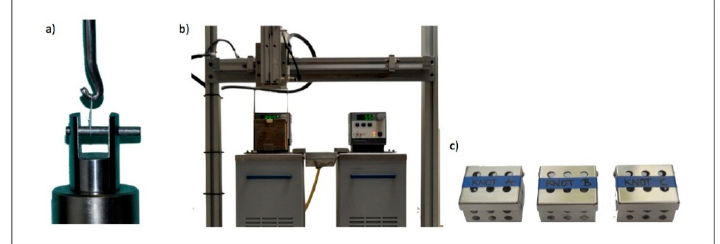
Figure 2. Mechanical and physical tests. ( a ) Hydraulic grip of the Universal